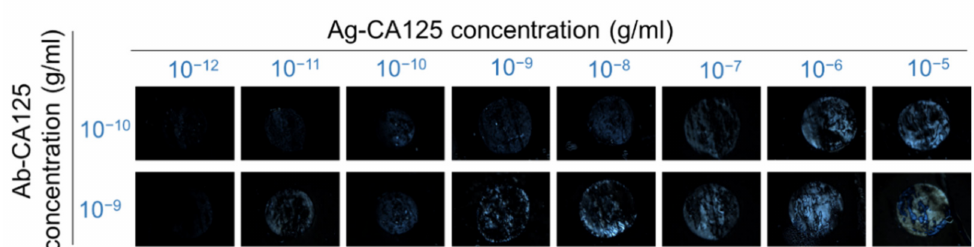
Figure 9. Optical textures of planarly aligned LCLC when the cancer biomarker CA125 was reacted with immobilized anti-CA125 antibody. The LCLC-based immunoassay was performed with an aqueous solution of 14-wt% DSCG as the sensing medium in contact with 10 − 10 or 10 − 9 g/mL anti-CA125 antibody immobilized on the PI-coated glass surface, followed by reaction with 10 − 12 –10 − 5 g/mL CA125. The ratios of reduced transmittance, T (cid:107) / T ⊥ , were calculated for both antibody immo- bilization concentrations and were plotted against CA125 concentration at representative wavelengths of 450, 600, and 750 nm, as shown in Figure 10. Similar to Figure 8 for the plots of T (cid:107) / T ⊥ versus the concentration of the anti-CA125 antibody, a negative and lin- ear correlation was found between the T (cid:107) / T ⊥ ratio and the CA125 concentration, with the absolute values of T (cid:107) / T ⊥ and the slope of the linear regression line increased with increasing wavelengths of the incident light (Figure 10). Because the T ⊥ values obtained at 10 − 10 g/mL anti-CA125 antibody were generally lower than those at 10 − 9 g/mL anti- CA125 antibody, the absolute values of T (cid:107) / T ⊥ at each CA125 concentration and the